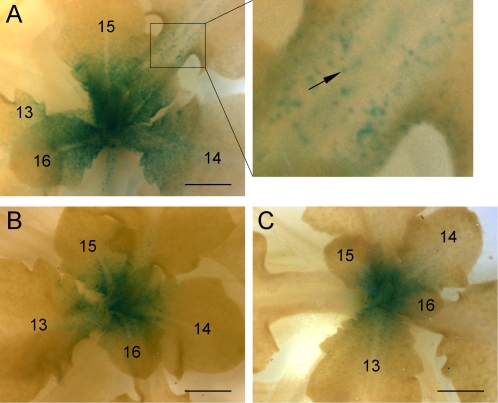
Histochemical detection of GUS in 31-day-old wild type Col-0 plants containing the CycB1;2::GUS reporter.(A) Untreated plants as control. Inset is an enlarged part of the petiole to indicate the individually stained cells (arrow). (B) Plants wounded on ten successive days. (C) Plants sprayed three times over 10 days with MeJA (100 µM) Numbers indicate leaf number. Scale bar, 1 mm.